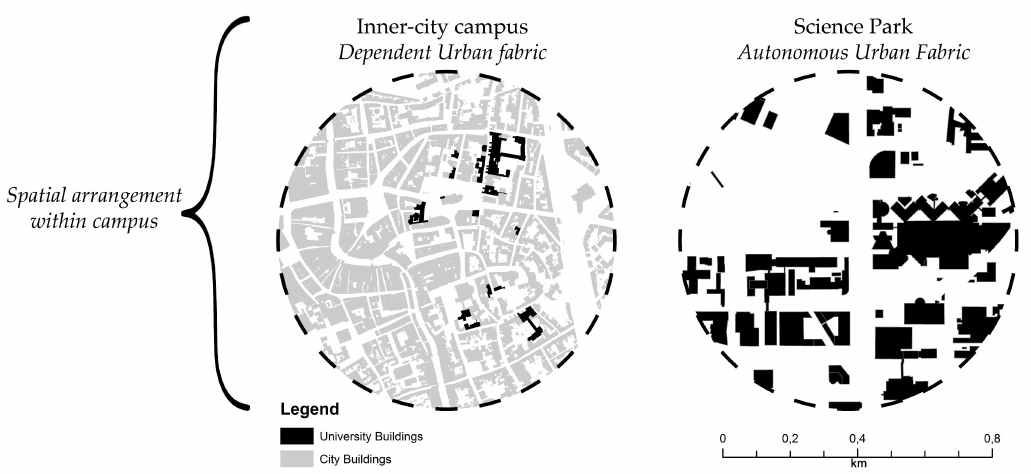
Figure 3. Buildings and public spaces: built (black and grey) and unbuilt